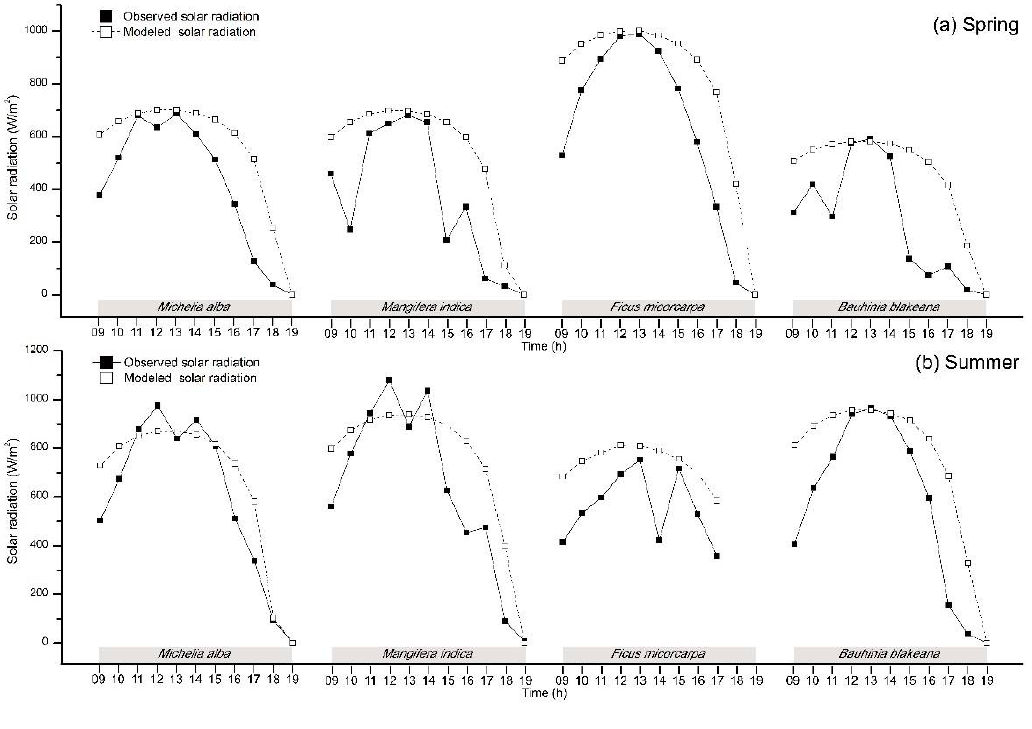
Table 4. Quantitative measures of ENVI-met model performance with observed data in treeless sites *.